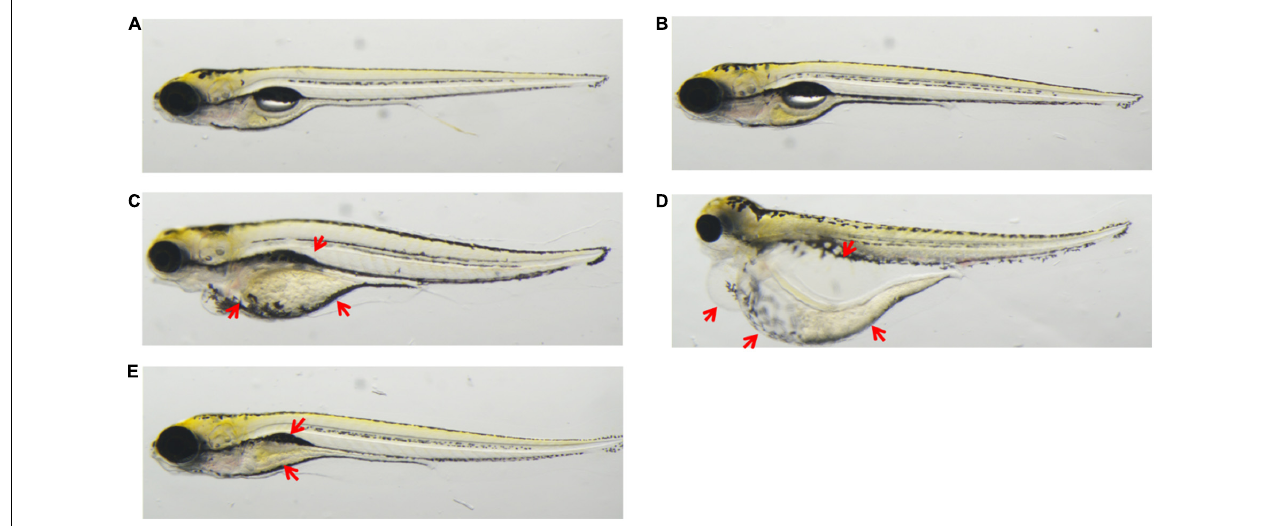
FIGURE 1 | Application: triptolide, aconitine, chlorogenic acid, treatment to zebrafish at 5 dpf. (A) Untreated. (B) 0.5% DMSO. (C) 0.1 µ M of triptolide treatment led to zebrafish renal edema, pericardial edema, and cardiovascular toxicity. (D) 100 µ M of aconitine treatment led to zebrafish having renal edema and pericardial edema. (E) 100 µ M of chlorogenic acid treatment led to zebrafish showing swim bladder loss and delayed yolk sac absorption.